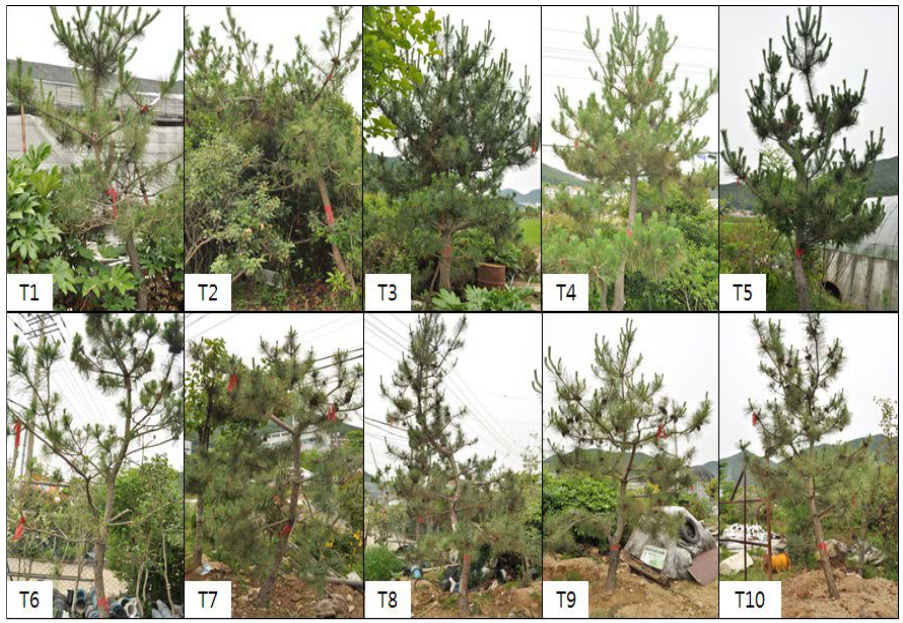
Figure 1. Pine wood nematode (PWN)-injected trees (T1–T5, T9 and T10) and non-injected trees (T6–T8).